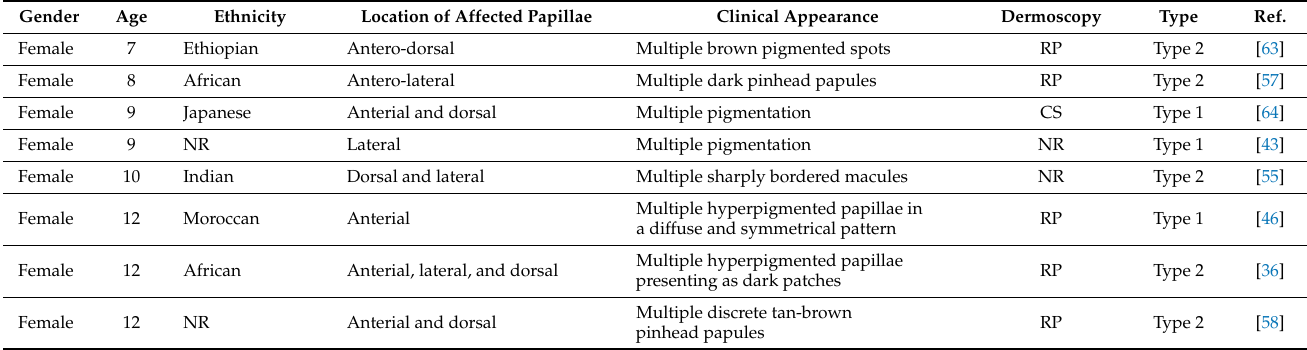
Table 1. Characteristics of PFP of the tongue as reported in selected